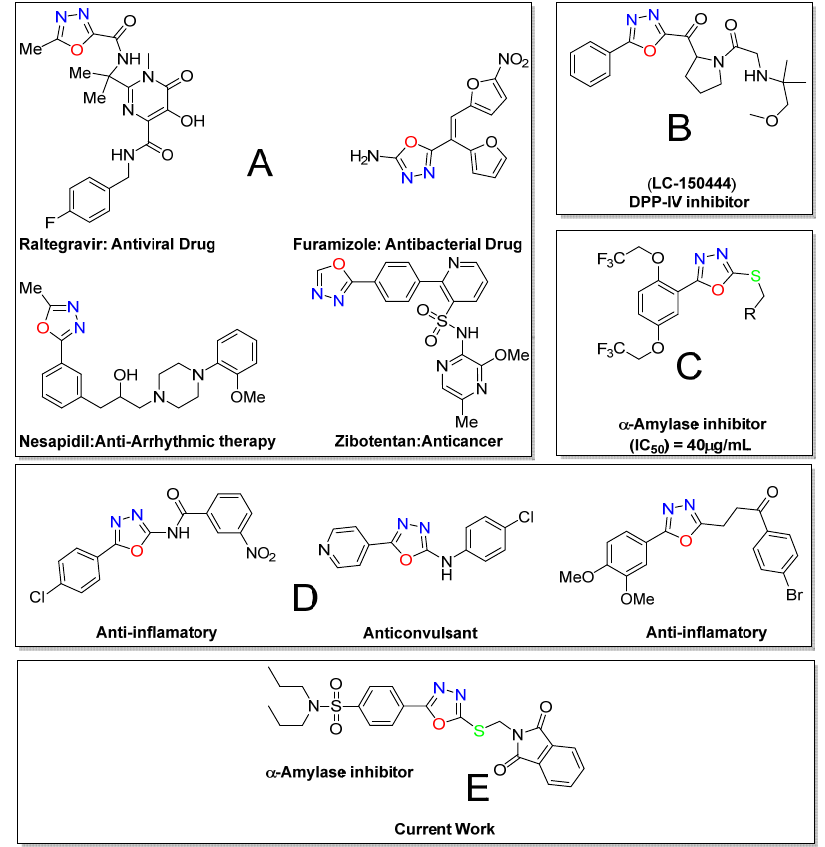
Figure 1. Schematic representation of the 1,3,4-oxadiazole moiety: ( A ) in commercial drugs; ( B ) in pre-clinical trials; ( C ) as α -amylase inhibitor; ( D ) in versatile biological activities; and ( E ) in current